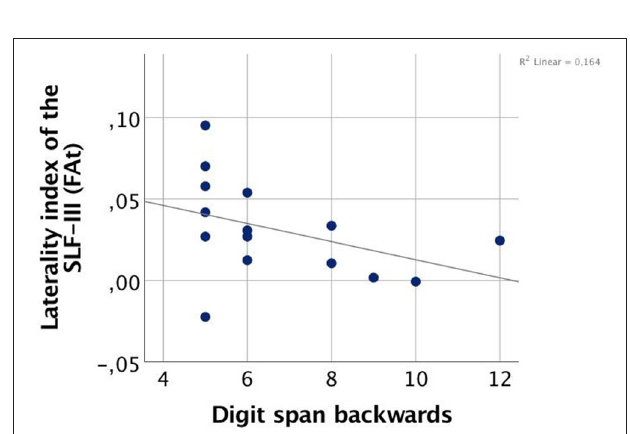
FIGURE 3 | Correlation between FA-based laterality index of the superior longitudinal fasciculus (SLF) III and working memory performance in clinical high-risk females